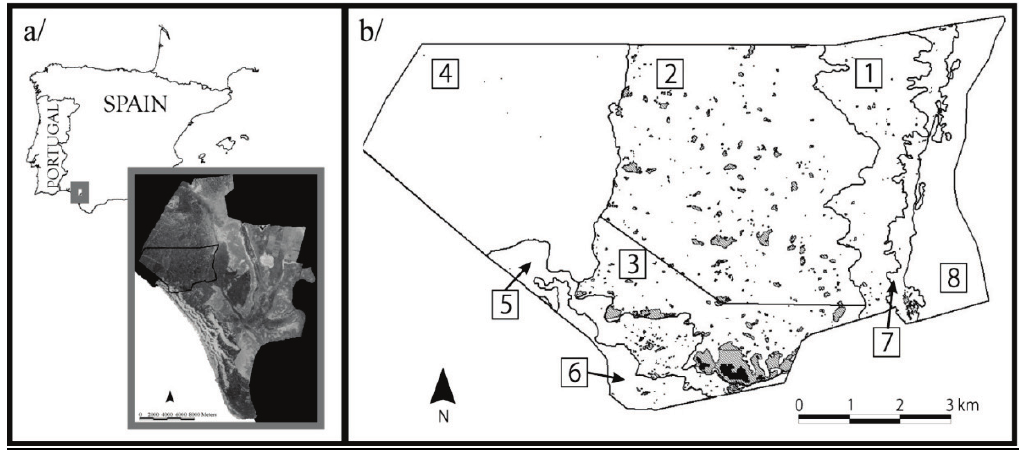
Figure 1. (a) Location of Doñana National Park in southwestern Spain. Solid black line delimits Doñana Biological Reserve (study area). (b) Study area with the Ecosections as defined in this work: 1. Low stabilized sands (exorheic zone) [LOW SANDS]; 2. Northern part of wet high stabilized sands (endorheic zone) [NORTHERN SANDS]; 3. Southern part of wet high stabilized sands (endorheic zone) [SOUTHERN SANDS]; 4. Dry high stabilized sands (arheic zone) [DRY SANDS]; 5. Semi-stabilized dunes [SEMI-STABILIZED DUNES]; 6. Mobile dunes [DUNES]; 7. Ecotone marshes-stabilized sands [ECOTONE MARSHES-SANDS]; 8. Marshes (excluded from the study).